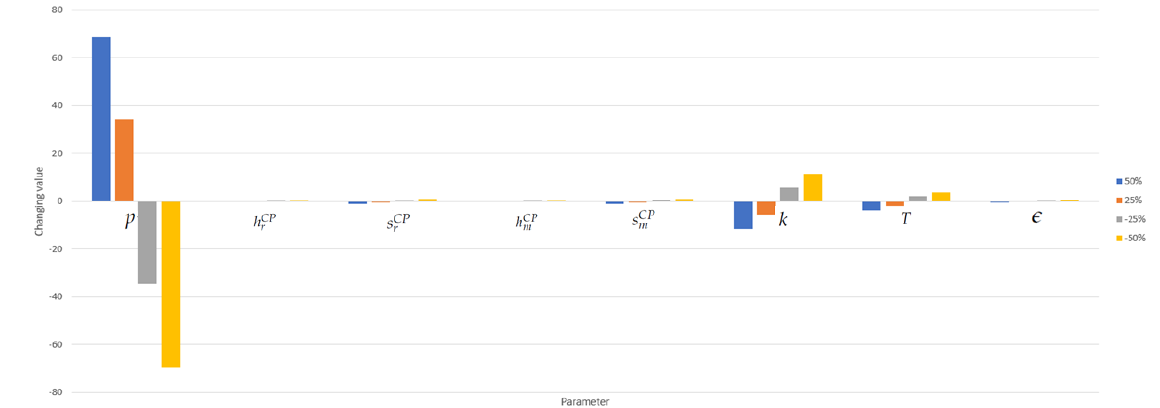
Figure 3. Sensitivity analysis of the parameters between the range of − 50% to +